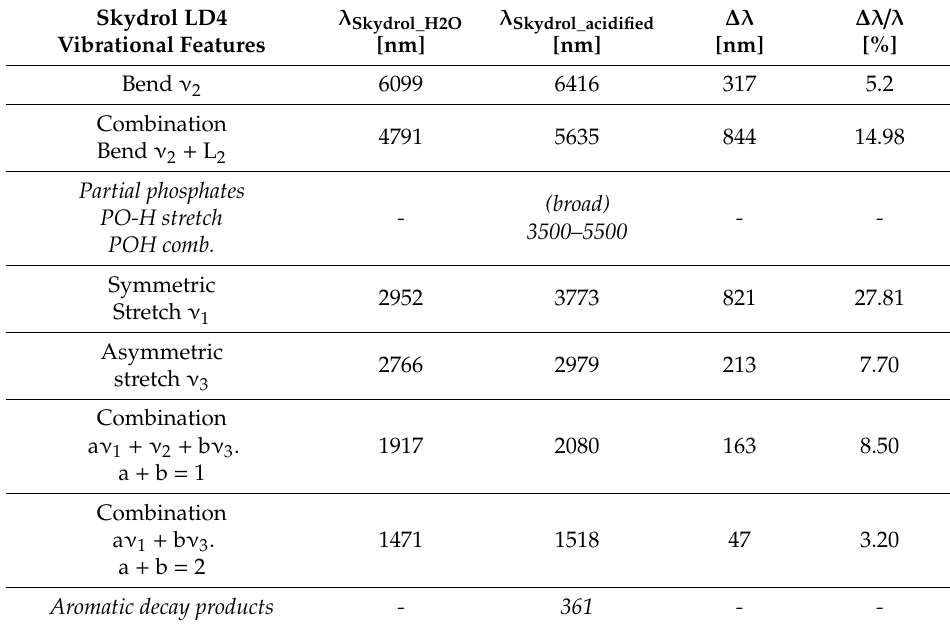
Table A2. Wavelengths of water vibrational features in Skydrol LD4 (column 2) as compared to those vibrational features that arise after water contamination and thermal degradation (column 3). Columns 4 and 5 list the respective wavelength shifts. While most features derive from parent water vibrational features, those in italic letters are degradation and / or TAN specific.